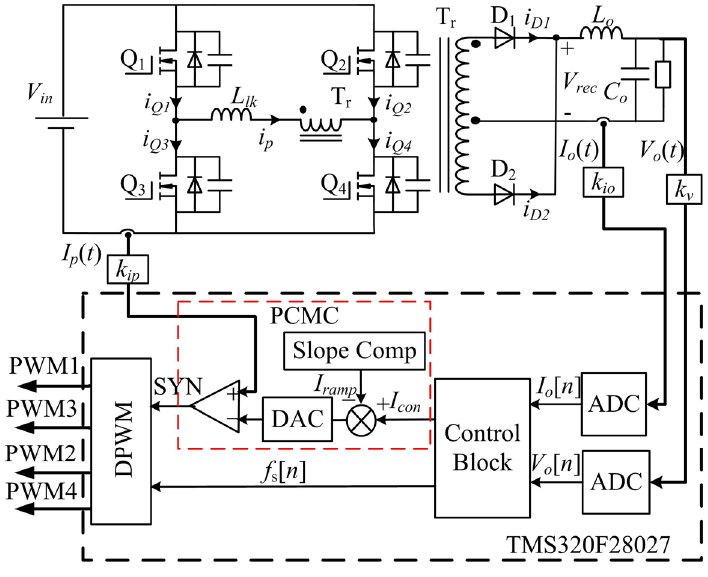
Figure 16. Closed-loop system block